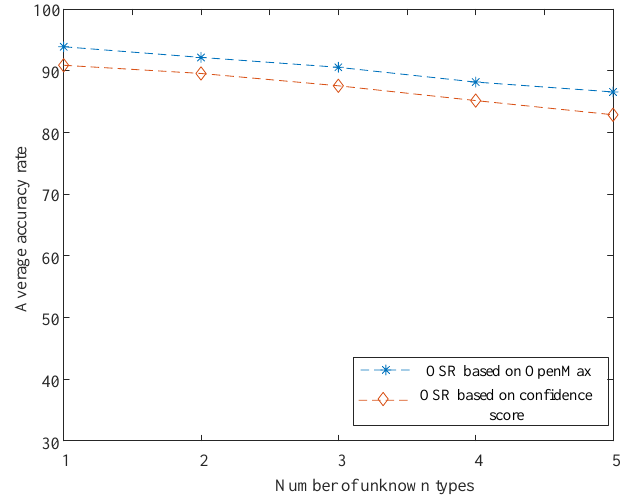
Figure 18. Recognition results of different open set environments.